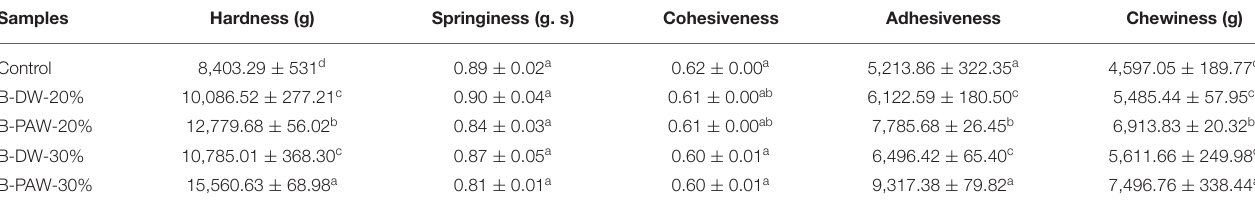
TABLE 3 | Texture determination of steamed bread.